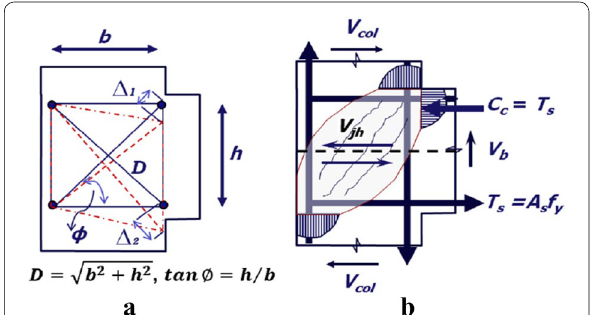
Fig. 25 Parameter for calculation of joint shear load (Shafaei et al. 2014): a joint shear deformation b Joint shear